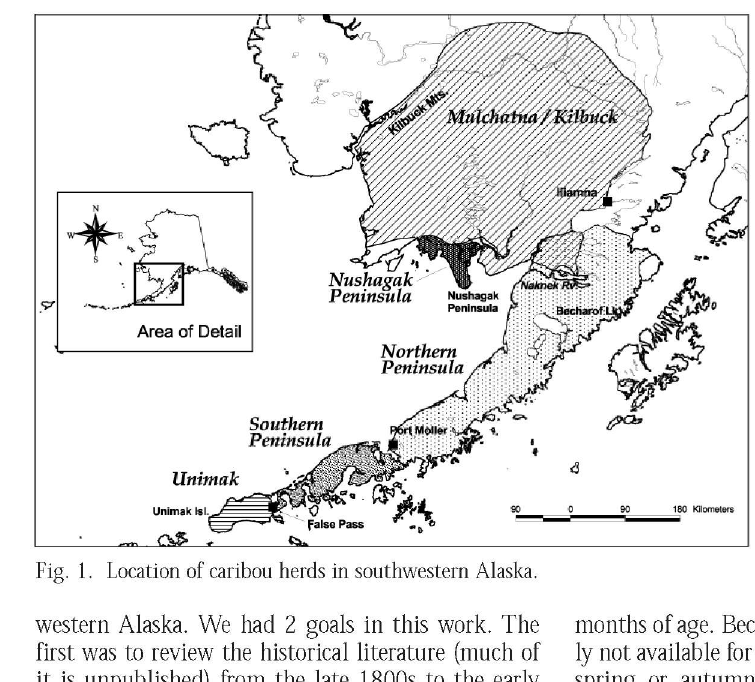
Fig. 1. Location of caribou herds in southwestern